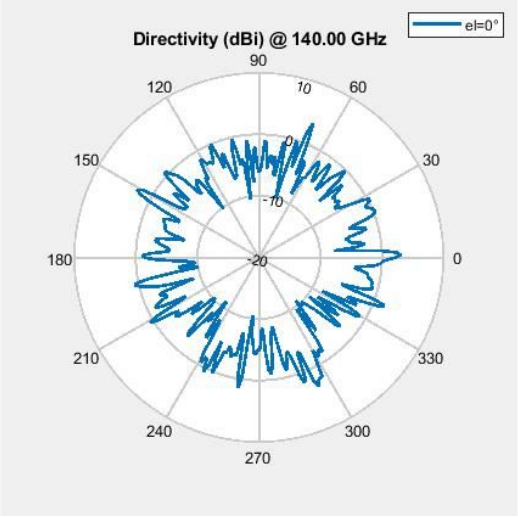
Figure 10. Azimuth pattern of Minkowski fractal antenna.